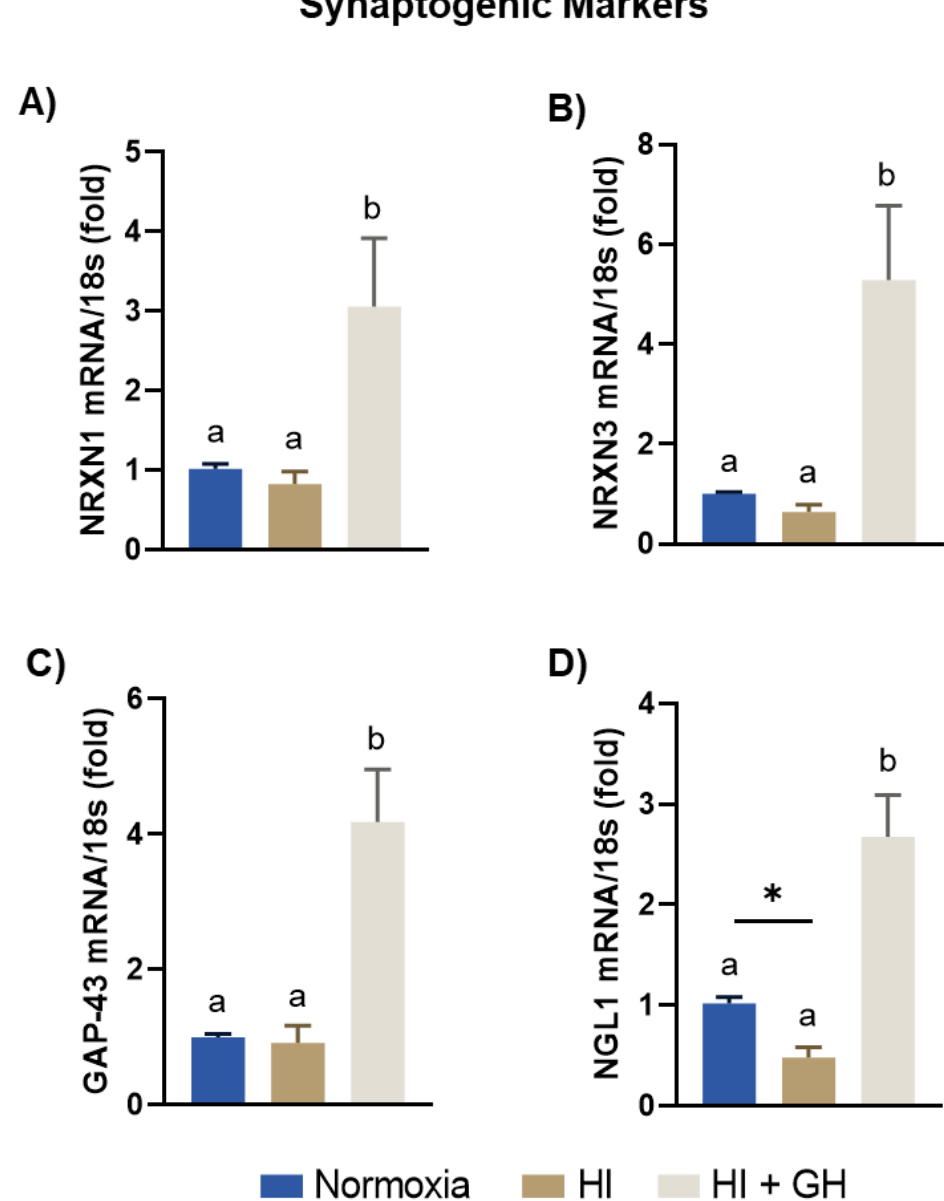
Figure 6. Effects of growth hormone (GH) upon the expression of synaptogenic markers after exposing pallial cultures to HI injury. Panels show the expression of: ( A ) NRXN1, ( B ) NRXN3, ( C ) GAP-43, and ( D ) NGL1 mRNAs, determined by RT-qPCR, under each incubation condition (normoxia, HI, or HI + GH). Relative mRNA expression values were corrected by the comparative threshold cycle (Ct) method and employing the formula 2 − ∆∆ CT . Ribosomal 18s RNA was used as the housekeeping gene. Bars represent mean ± SEM (from 4 independent experiments in duplicate; n = 8 cultures per group). Groups with different letters are significantly different by one-way ANOVA with Tukey’s post hoc test ( p < 0.05). An unpaired Student’s t test was used to compare normoxia versus HI (panel D ), and asterisks (*) indicate a significant difference (* p < 0.05).